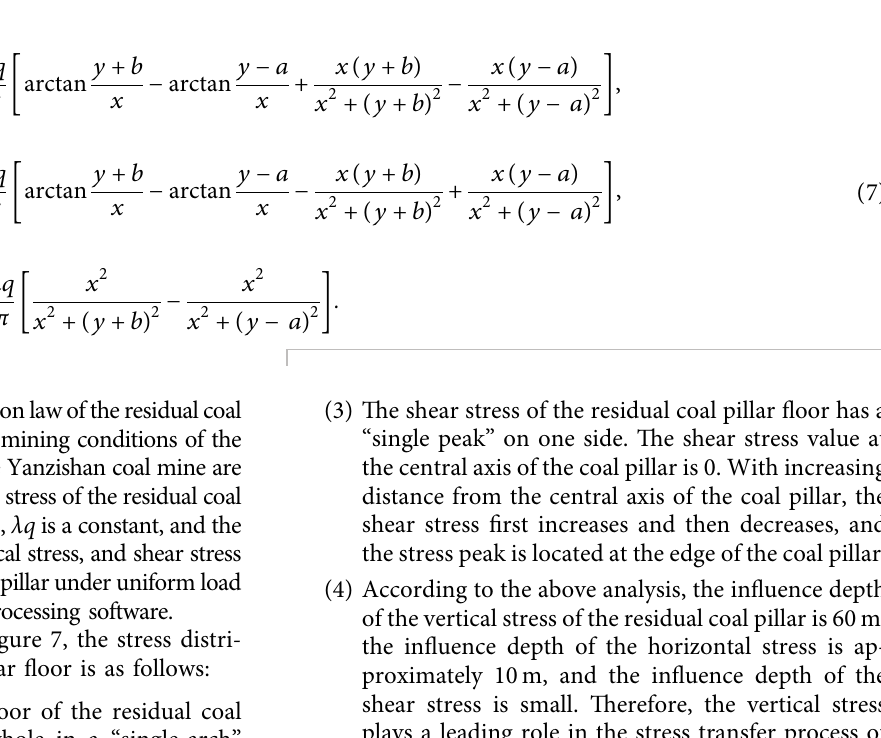
Figure 6: Stress calculation model of the residual coal